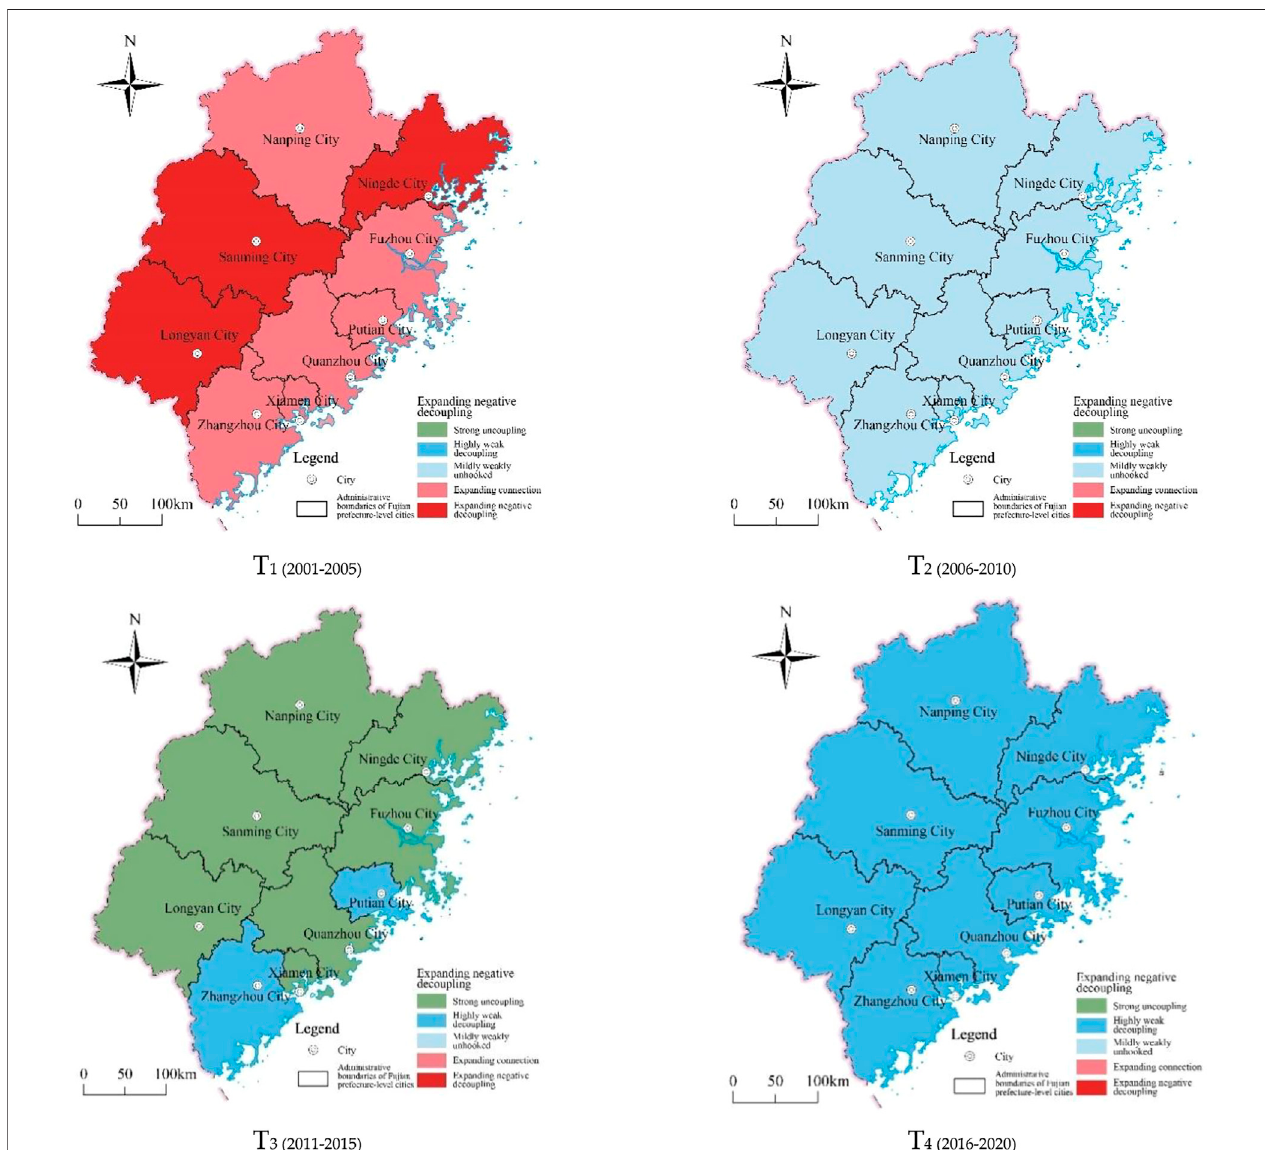
FIGURE 2 | Spatial distribution of decoupling status between carbon emissions and economic growth of prefecture-level cities in Fujian Province.